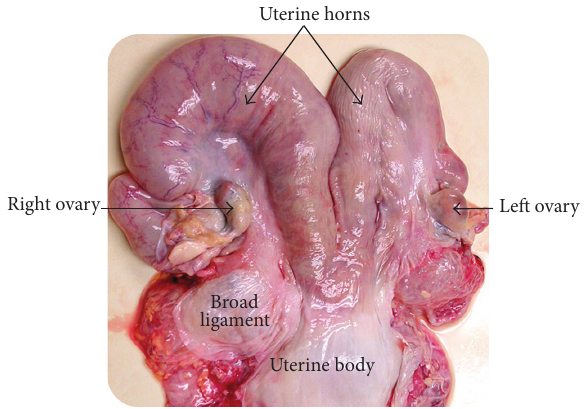
Figure 1: The anatomy of the cattle